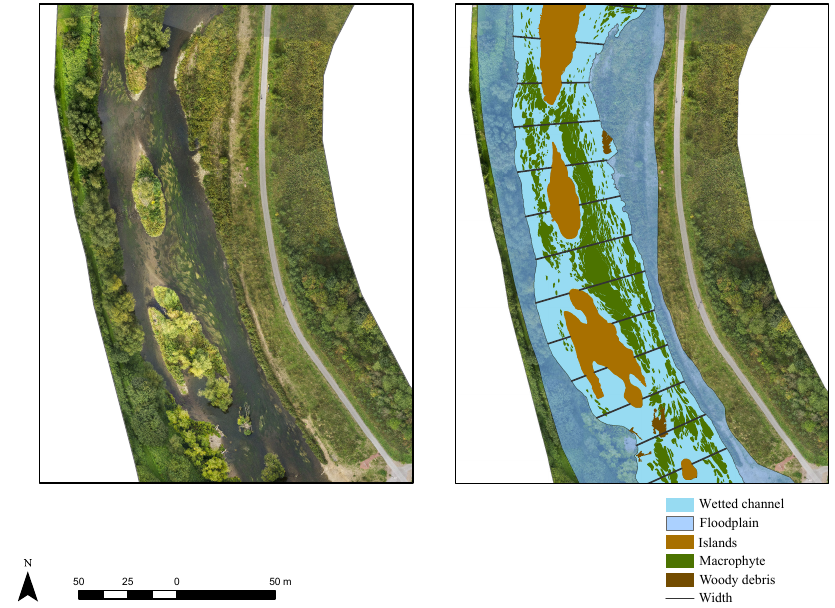
Figure 2. Analysis of aerial photos. A representative river section of the second restored reach is